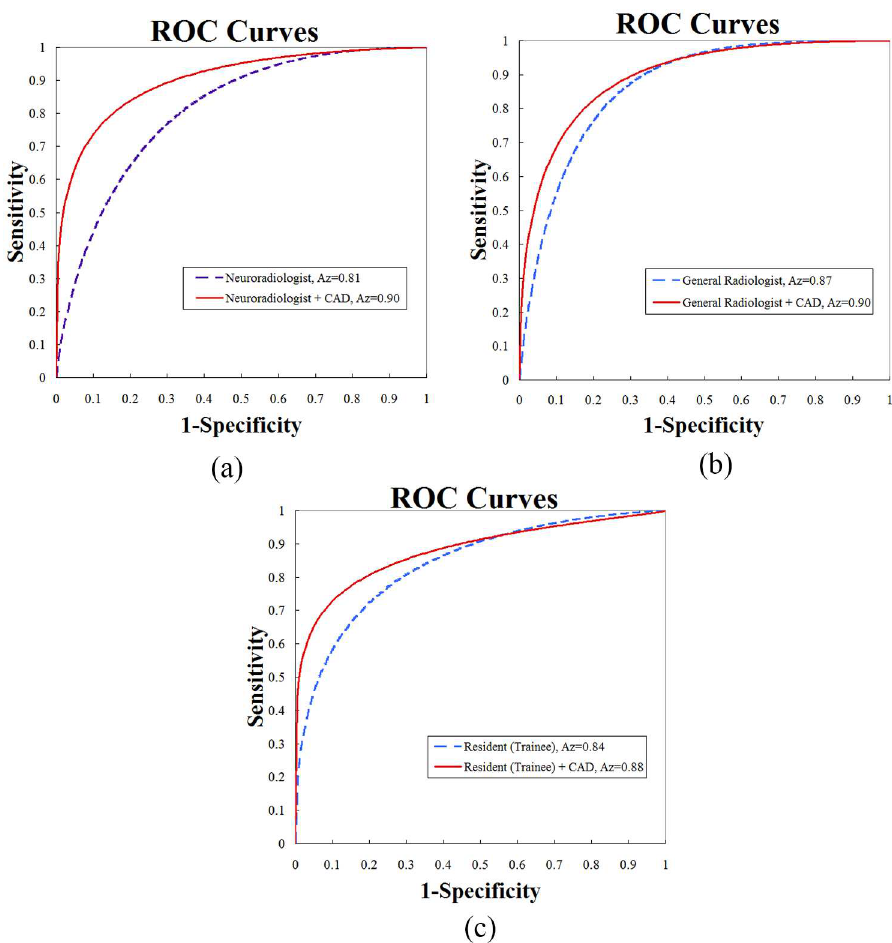
Fig 3. Trade-offs between the sensitivity and specificity of the (a) neuroradiologist, (b) general radiologist, and (c) resident (trainee) with and without the computer-aided diagnosis (CAD) system illustrated by receiveroperating characteristic (ROC)